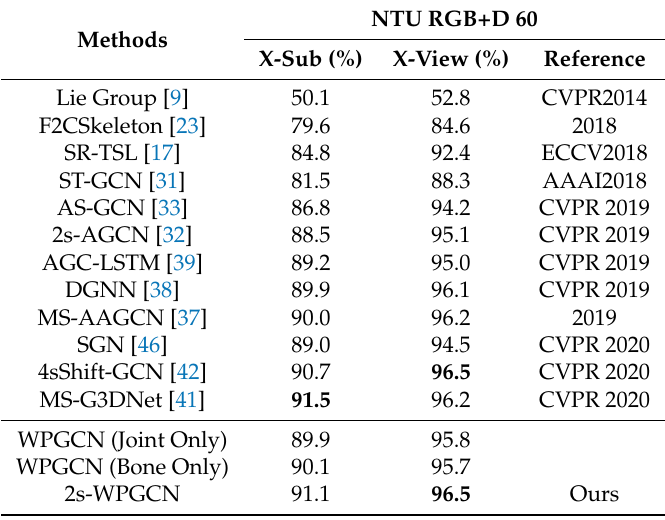
Table 5. Recognition accuracy comparison against state-of-the-art methods on the NTU RGB+D 60 dataset. The best results are shown in